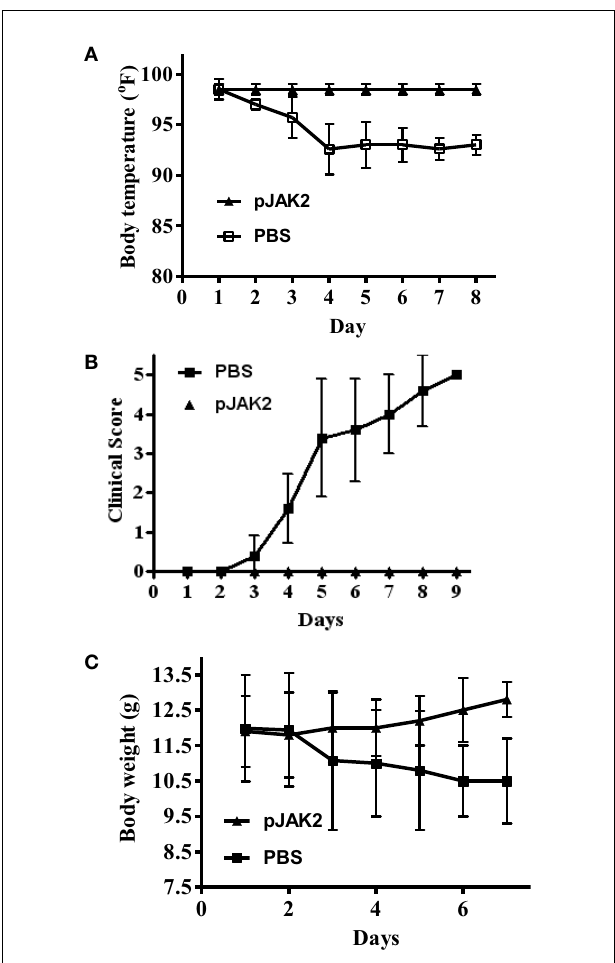
FIGURE 2 | SOCS antagonist protects against the onset of symptoms in influenza A virus infection . C57BL/6 mice were infected intranasally as in Figure 1 on day 0 with 10 (cid:2) LD50 of influenza A PR/8 virus. Starting with day 1, daily injections of PBS or pJAK2 (200 μ g) were given i.p. All the PBS-injected mice were dead by day 9, while the pJAK2-treated mice survived the virus challenge. Changes in body temperature in Fahrenheit are indicated in (A) . The p value between pJAK2 peptide versus PBS was 0.001. Clinical score (see text) is shown in (B) , where p = 0.002 between pJAK2- versus PBS-treated mice. Body weight in grams is recorded in (C) . The significance of difference between pJAK2 and PBS is p = 0.002.